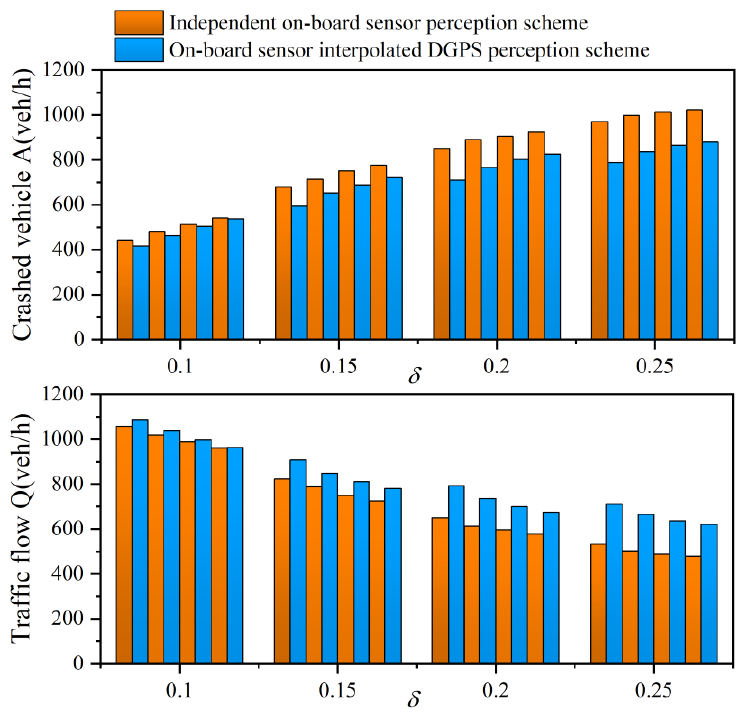
Figure 9. Traffic flow and Accidents for varying perceptual error size δ with an independent on-board sensor perception scheme and an on-board sensor interpolated DGPS perception scheme in a partial CAV scenario. The data correspond to 80%, 60%, 40%, and 20% CAV penetration from left to right at each δ .